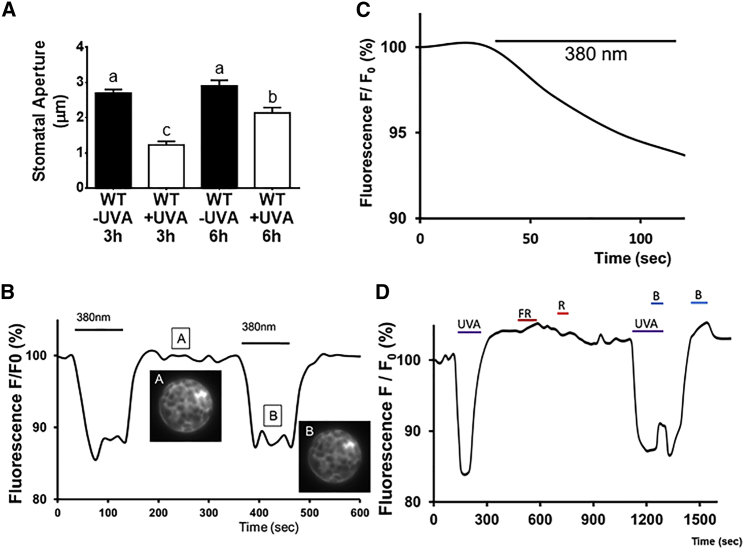
Effects of UVA Radiation on Stomatal Opening and δ-FlincG Fluorescence(A) UVA radiation inhibits blue- and red-light-induced stomatal opening. Isolated Arabidopsis epidermis were illuminated with a combination of 10 μmol m−2 s−1 blue (λmax = 470 nm) and 50 μmol m−2 s−1 red (λmax = 660 nm) light in the presence or absence of 10 μmol m−1 s−1 UVA (λmax = 380 nm) in 10 mM MES/KOH, 50 mM KCl, pH 6.15. Stomatal apertures were measured after 3 h and 6 h illumination. Data represent means (+/− SEM) of 90 stomatal aperture measurements from three replicates. Statistical analyses were performed by one-way ANOVA with Tukey post hoc analysis, and letters show significant differences at p < 0.05.(B) A representative graph (n = 50) of the reversible decrease of δ-FlincG fluorescence observed in mesophyll protoplasts when illuminated with 10 μmol m−1 s−1 UVA (λmax = 380 nm). In the presence of UVA, the fluorescence decreases within seconds and reaches a plateau. In the absence of UVA, the fluorescence rapidly returns to its initial level. The lines labeled 380 nm represent the length of time the protoplasts were illuminated with UVA.(C) A representative measurement (n = 5) of δ-FlincG fluorescence from a guard cell on an isolated epidermal strip illuminated with UVA radiation (10 μmol m−1 s−1 [λmax = 380 nm]). The line labeled 380 nm represents the length of time the epidermal strip was illuminated with UVA.(D) Effect of light quality on δ-FlincG fluorescence. Fluorescence of mesophyll protoplasts from plant expressing δ-FlincG was measured when illuminated with UVA (λmax = 380 nm, 10 μmol m−1 s−1), blue (λmax = 470 nm, 20 μmol m−1 s−1), red (λmax = 680 nm, 15 μmol m−1 s−1) or far-red (λmax = 730 nm, 5 μmol m−1 s−1) light. Far-red and red light did not have a significant effect on the fluorescence levels. UVA decreases the fluorescence by 15%, and blue increases it by 2.5% (n = 3, p < 0.05). The lines represent the length of time the protoplasts were illuminated with UVA, far-red (FR), red (R), UVA, and blue (B) together or blue alone. The graph shown is representative of 3 independent experiments.See also Figures S1 and S3.